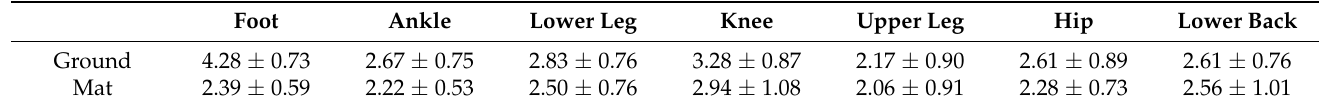
Table 3. Subjective feeling rating scale.